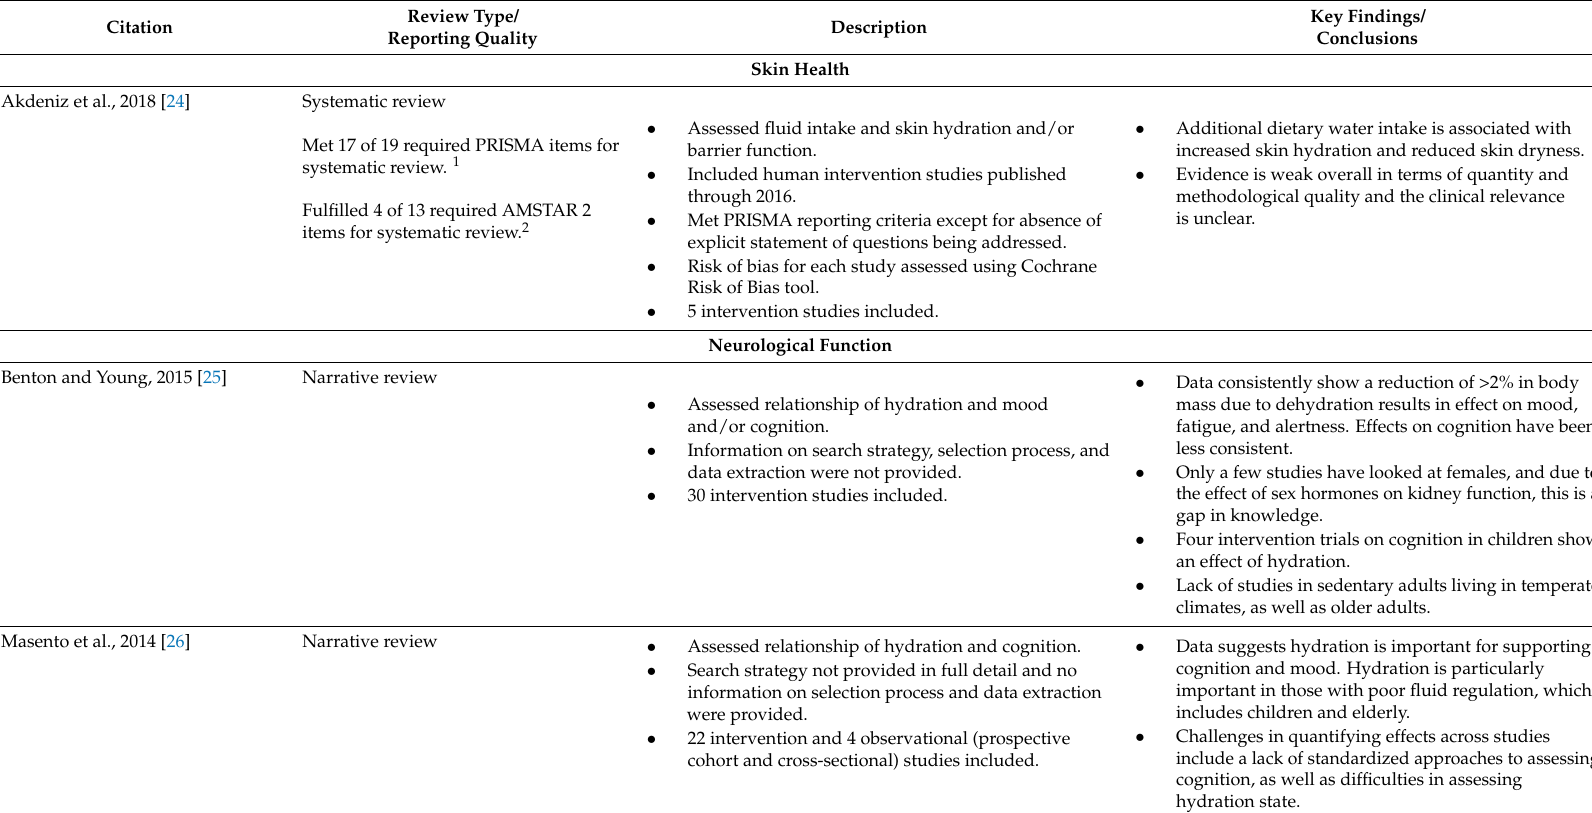
Table 1. Summary of key hydration